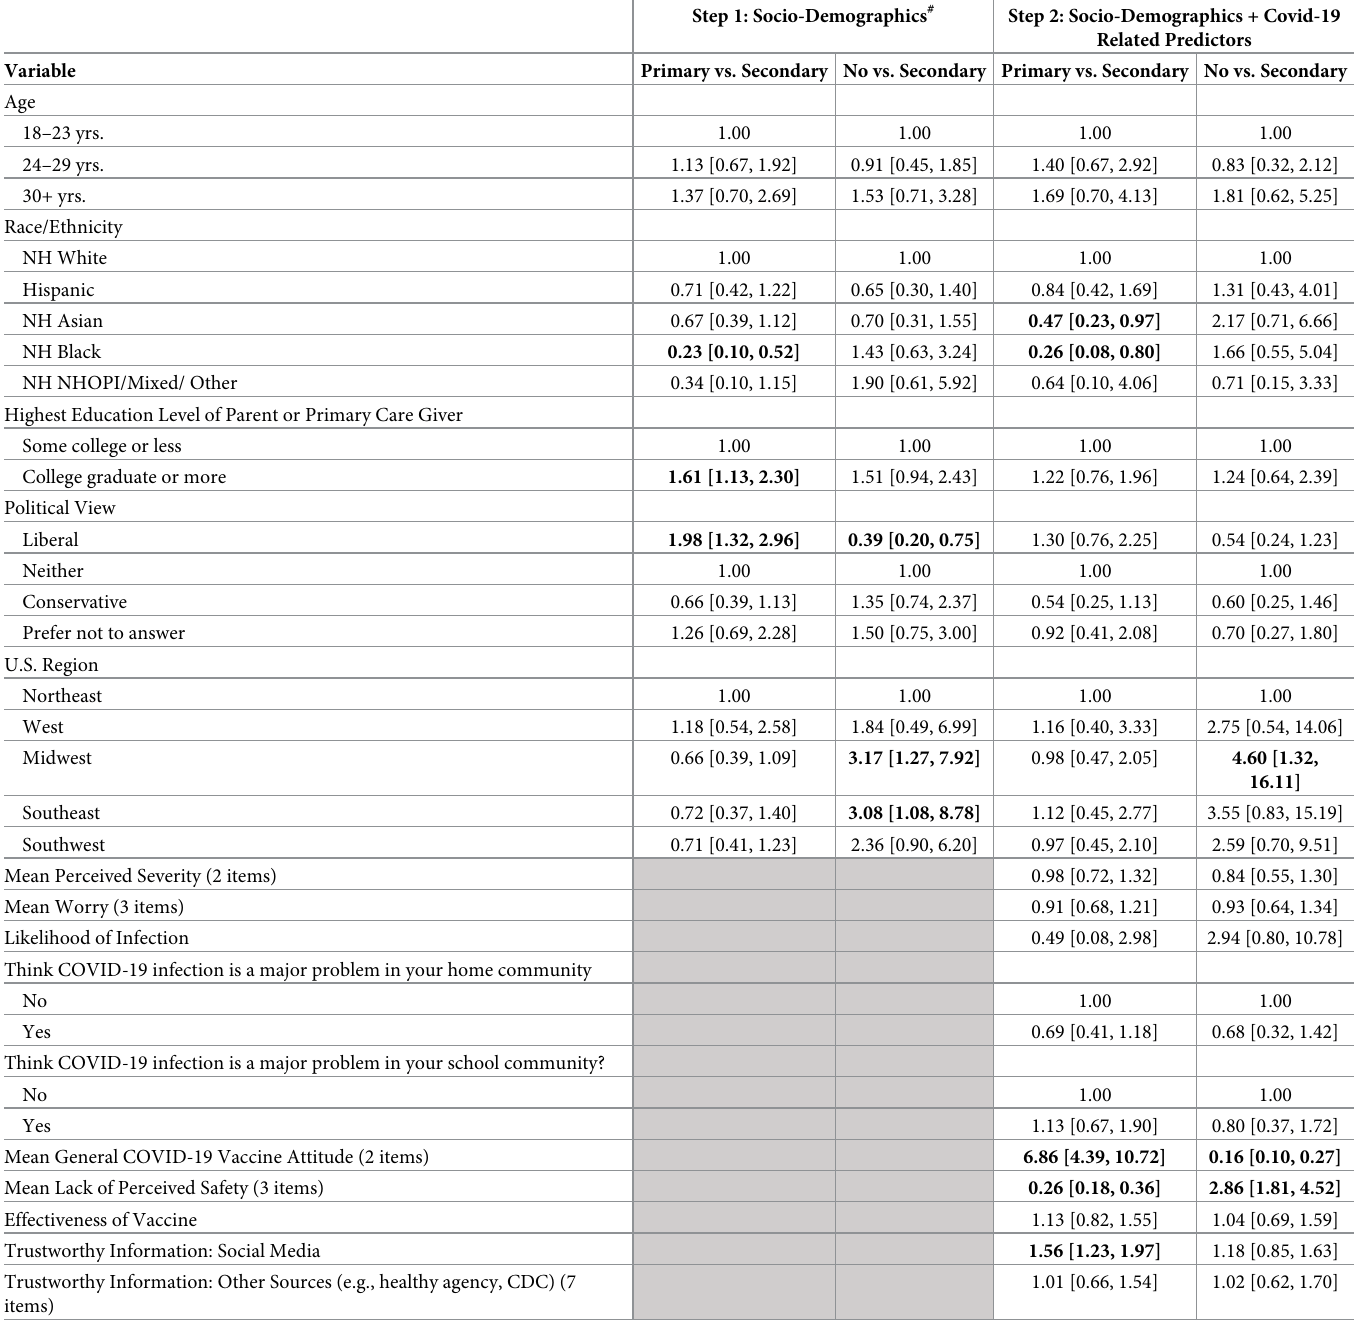
Table 3. Multivariable multinomial logistic